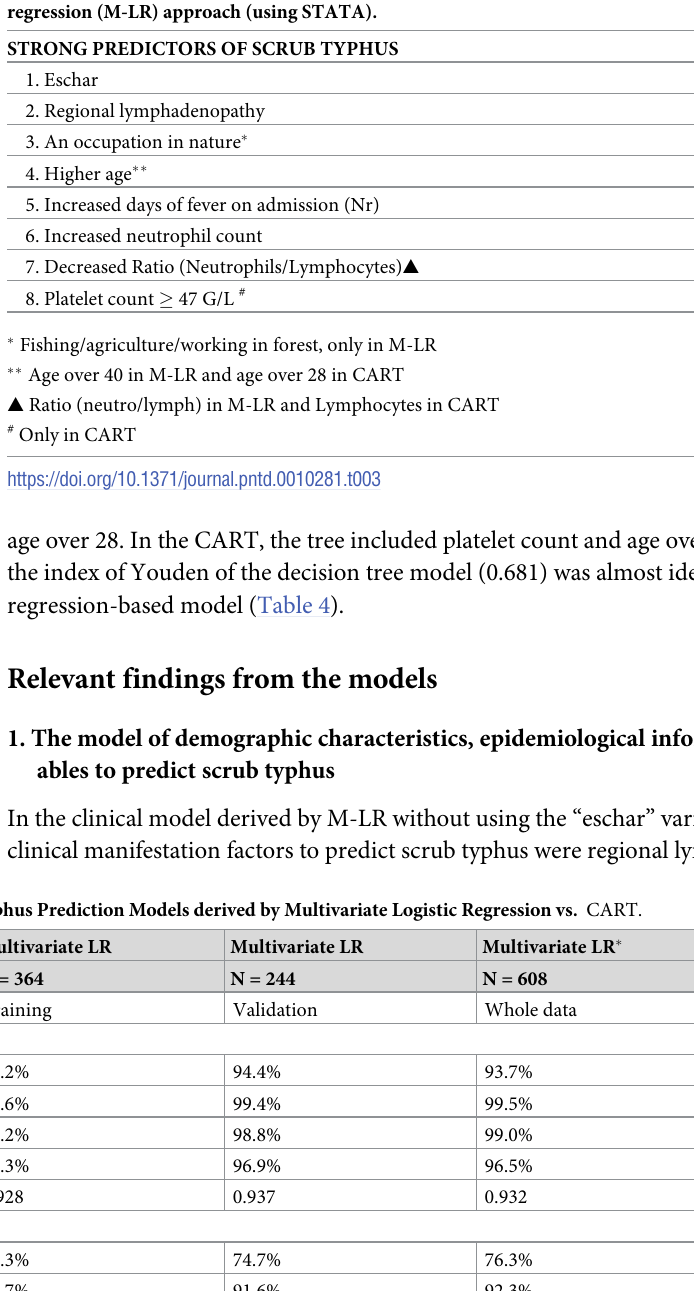
Table 3. The most relevant predictors of scrub typhus selected by CART (using R) and by the multivariate logistic regression (M-LR) approach (using STATA). STRONG PREDICTORS OF SCRUB TYPHUS